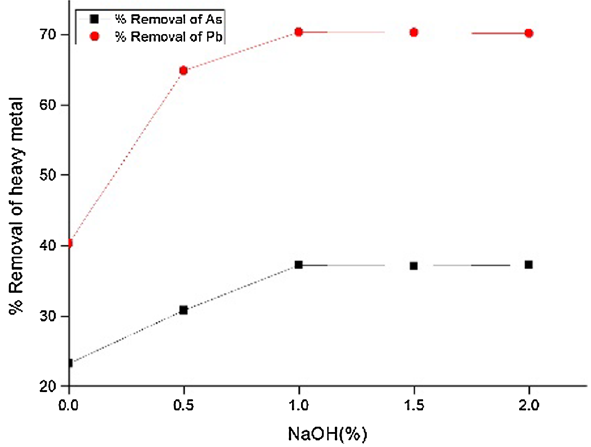
Fig. 1 Effect of NaOH concentration (%) on Pb and As